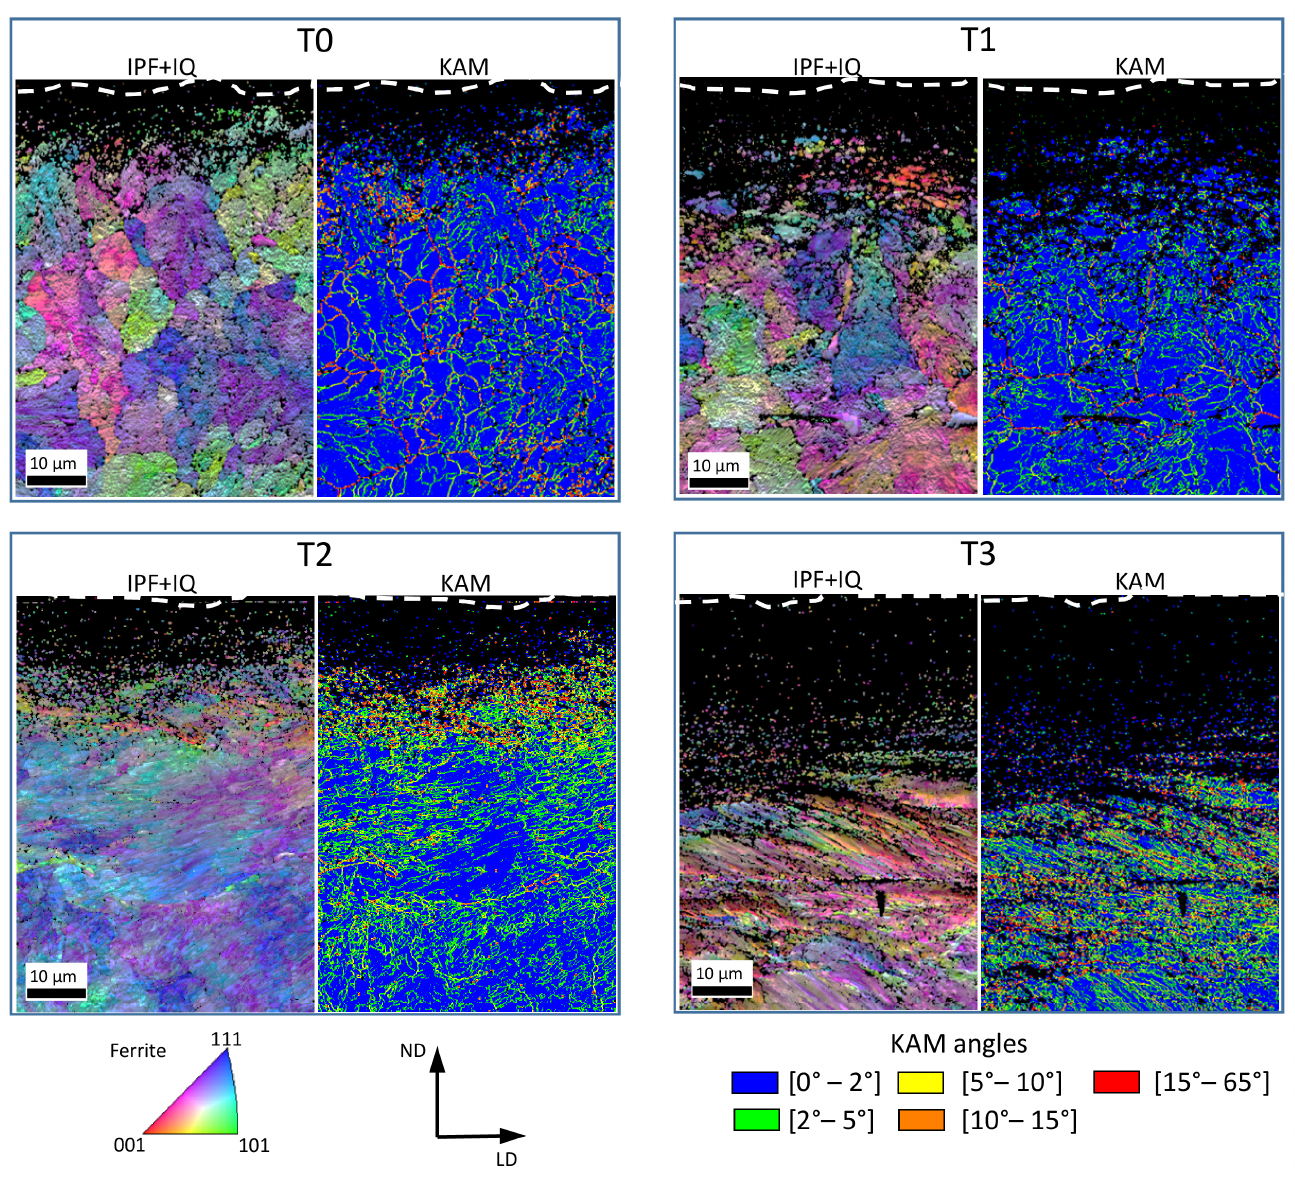
Figure A4. IPF map with IQ and KAM maps for the non-deformed state (T0) and the different testing conditions (T1, T2, T3), for Ring AT-C. The measurements were performed along the longitudinal direction.